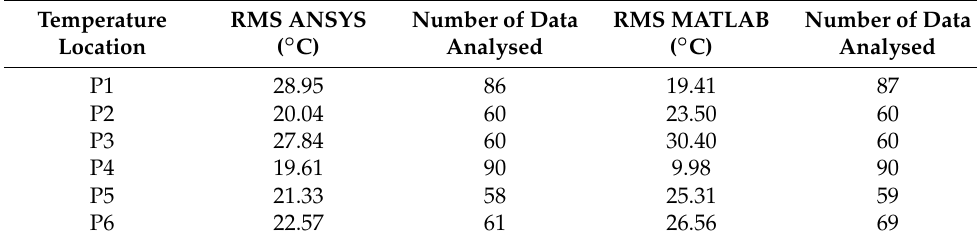
Table 5. Root mean square error ( ◦ C) between experimental and numerical